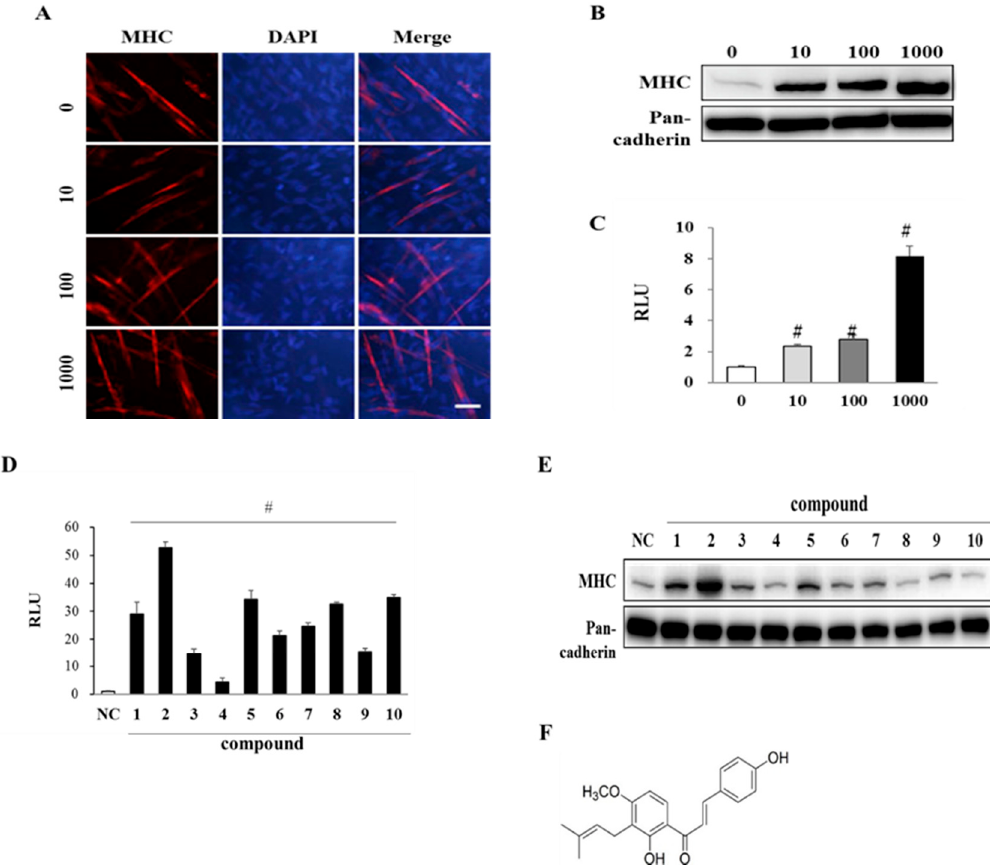
Figure 2. E ff ects of EAK and AK compounds on myogenesis of myoblasts. ( A ) C2C12 cells were di ff erentiated in di ff erentiation medium (DM) supplemented with EAK (10, 100, or 1000 ng / mL) for 3 days and immunostained with antibody to myosin heavy chain (MHC, red) and 4 ′ ,6-diamidino-2-phenylindole (DAPI, blue). Scale bar = 200 µ m. ( B ) Expression level of MHC was determined by Western blotting analysis. ( C ) C2C12 cells were transiently transfected with 4RTK-luciferase and MyoD-pBP plasmid, and then treated with EAK as described in materials and methods. MyoD transactivation is presented as relative luciferase activity (RLU). Data are expressed as mean ± standard deviation (SD). # p < 0.001 vs. 0 ng / mL of EAK. ( D ) C2C12 cells were transiently transfected with 4RTK-luciferase and MyoD-pBP plasmid, and then treated with AK compounds 1 – 10 (100 pM) for an additional 24 h. Data are expressed as mean ± standard deviation (SD). NC, negative control (DMSO); 1 – 10 , compounds 1–10. # p < 0.001 vs. NC. ( E ) C2C12 cells were di ff erentiated in the presence of each AK compounds 1 – 10 and then expression level of MHC was determined by Western blotting analysis. ( F ) Chemical structure of 4-HD.